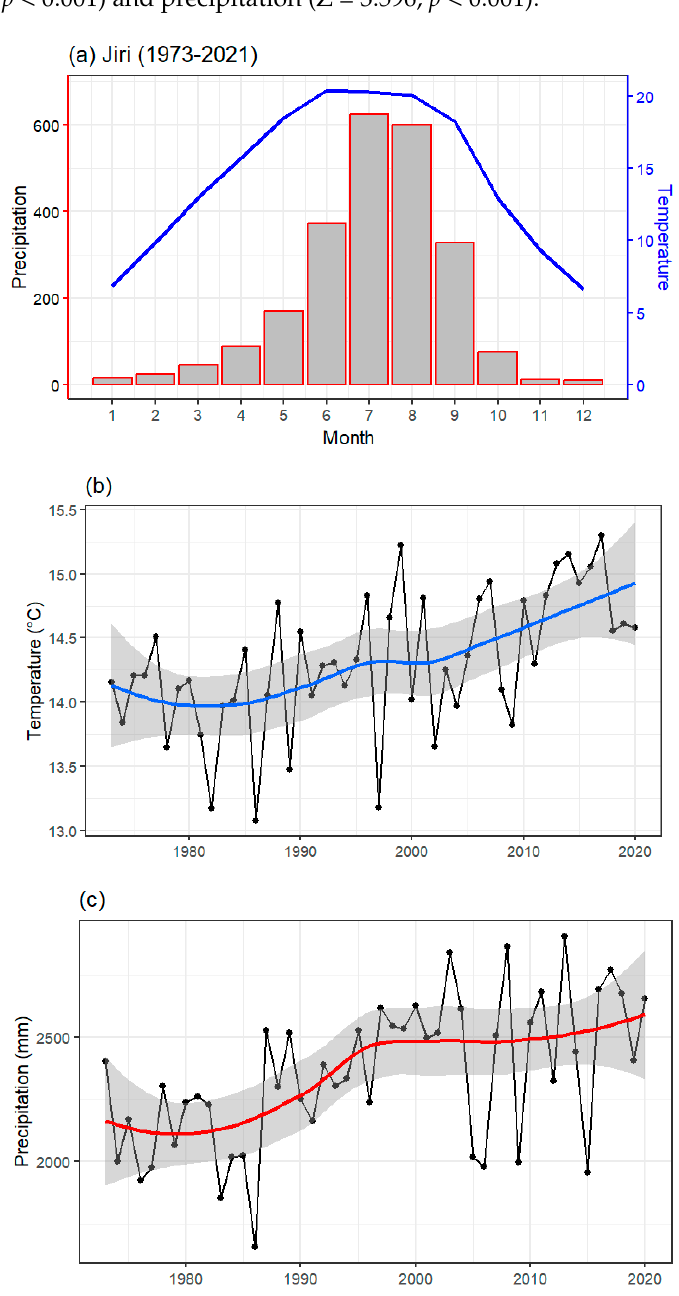
Figure 3. Trends of climate attributes for Jiri Nepal. ( a ) Climate diagram for Jiri, Nepal shows the mean monthly temperature (line) and the total monthly precipitation (bar). Months are numerically represented with January being 1 and December being 12. ( b ) Annual mean temperature. ( c ) Annual precipitation sum.